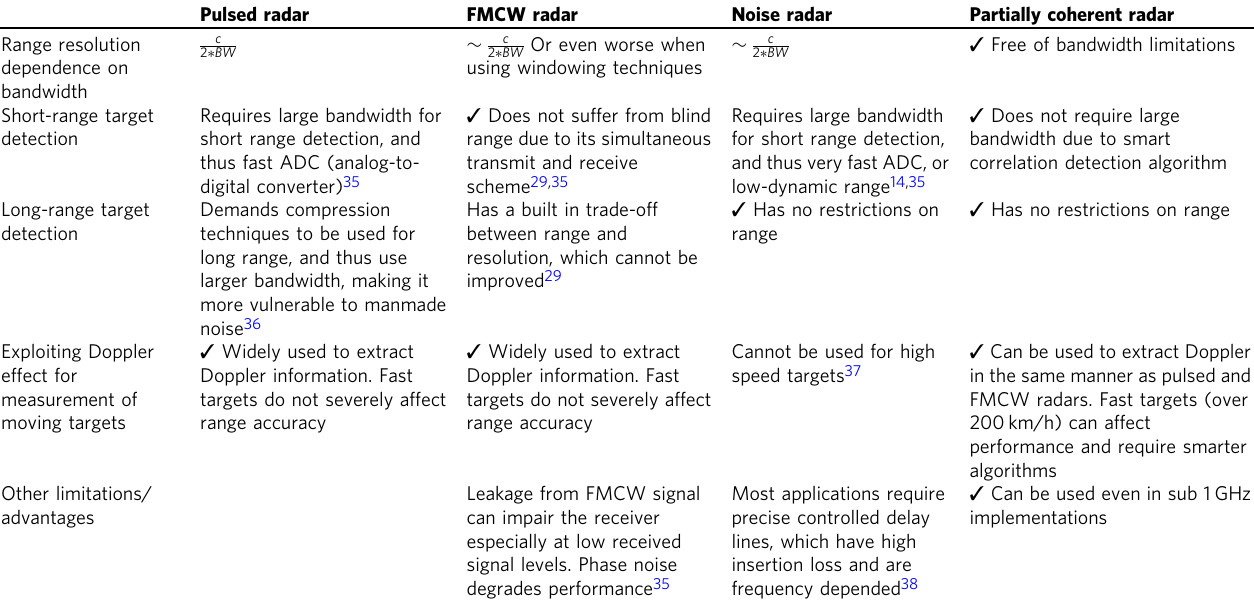
Table 1 Comparison between widely used radar implementations and the partially coherent radar Inherent differences between common radar technologies and Partially Coherent Radar